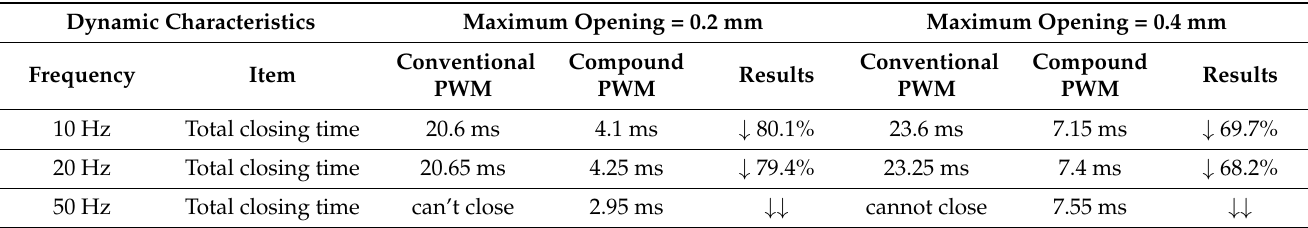
Table 3. Comparison of the total closing time during the de-energized